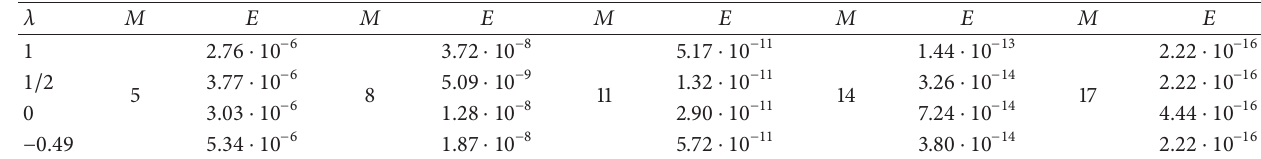
Table 3: Maximum absolute error 𝐸 for Example 9.